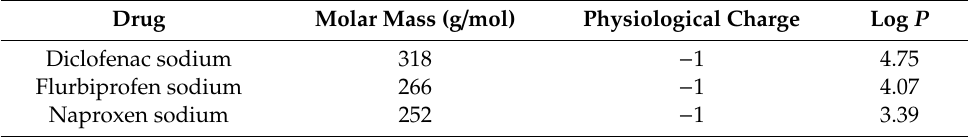
Table 1. Physicochemical properties of the three model drugs (source: ALOGPS from DrugBank). Drug Molar Mass (g/mol) Physiological Charge Log P Diclofenac sodium 318 − 1 4.75 Flurbiprofen sodium 266 − 1 4.07 Naproxen sodium 252 − 1 3.39